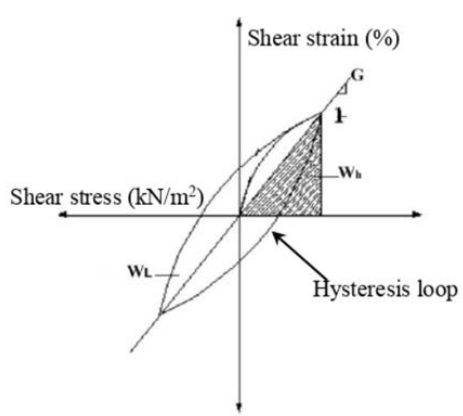
Figure A1. Hysteresis loop obtained from cyclic loading (Jaya et al . 2012).